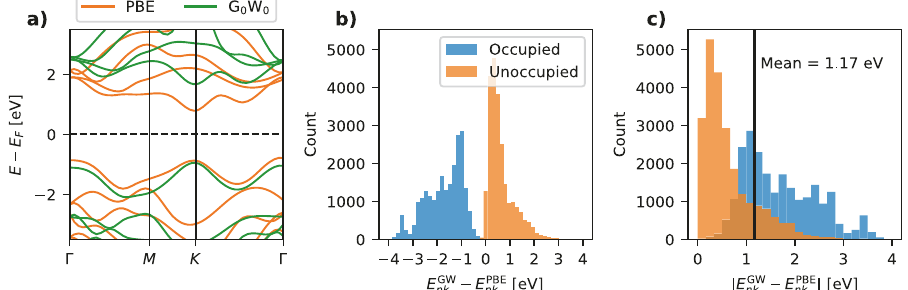
Fig. 1 G 0 W 0 data. a Example of PBE and G 0 W 0 band structures of monolayer MoS 2 . The prediction target data is the difference in energy between the PBE and G 0 W 0 energies. b Histogram of the G 0 W 0 corrections for all states in all materials. c Histogram of the absolute values of the G 0 W 0 corrections with a mean of 1.17